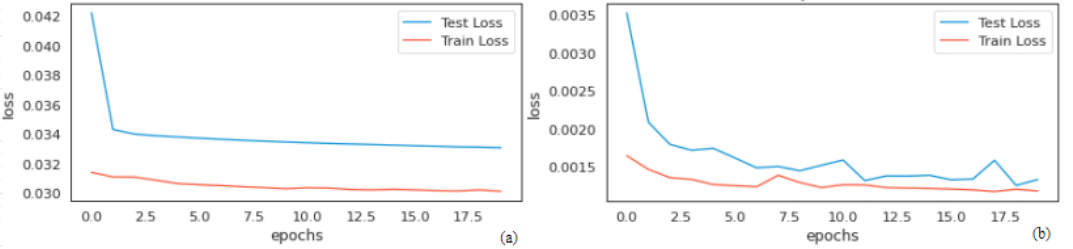
Figure 14. Model loss for ( a ): heaters and ( b ): pump